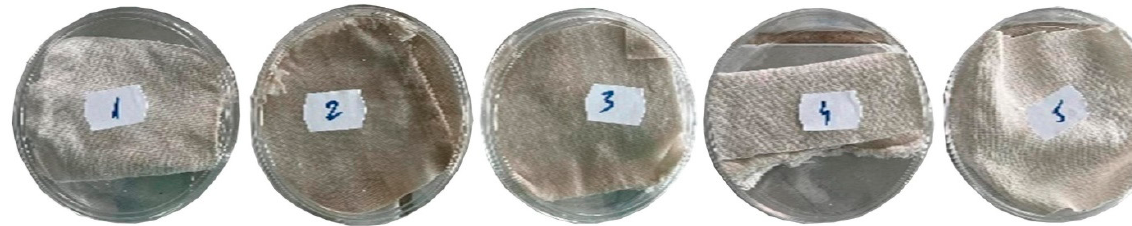
Figure 2. Preparation of cotton fabric samples for AgNP